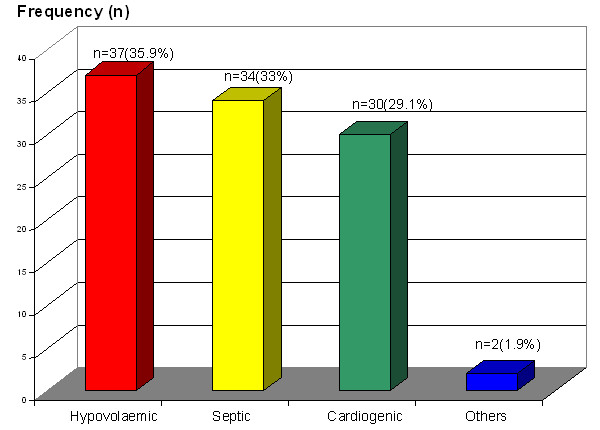
Distribution of type of shock among the study population.